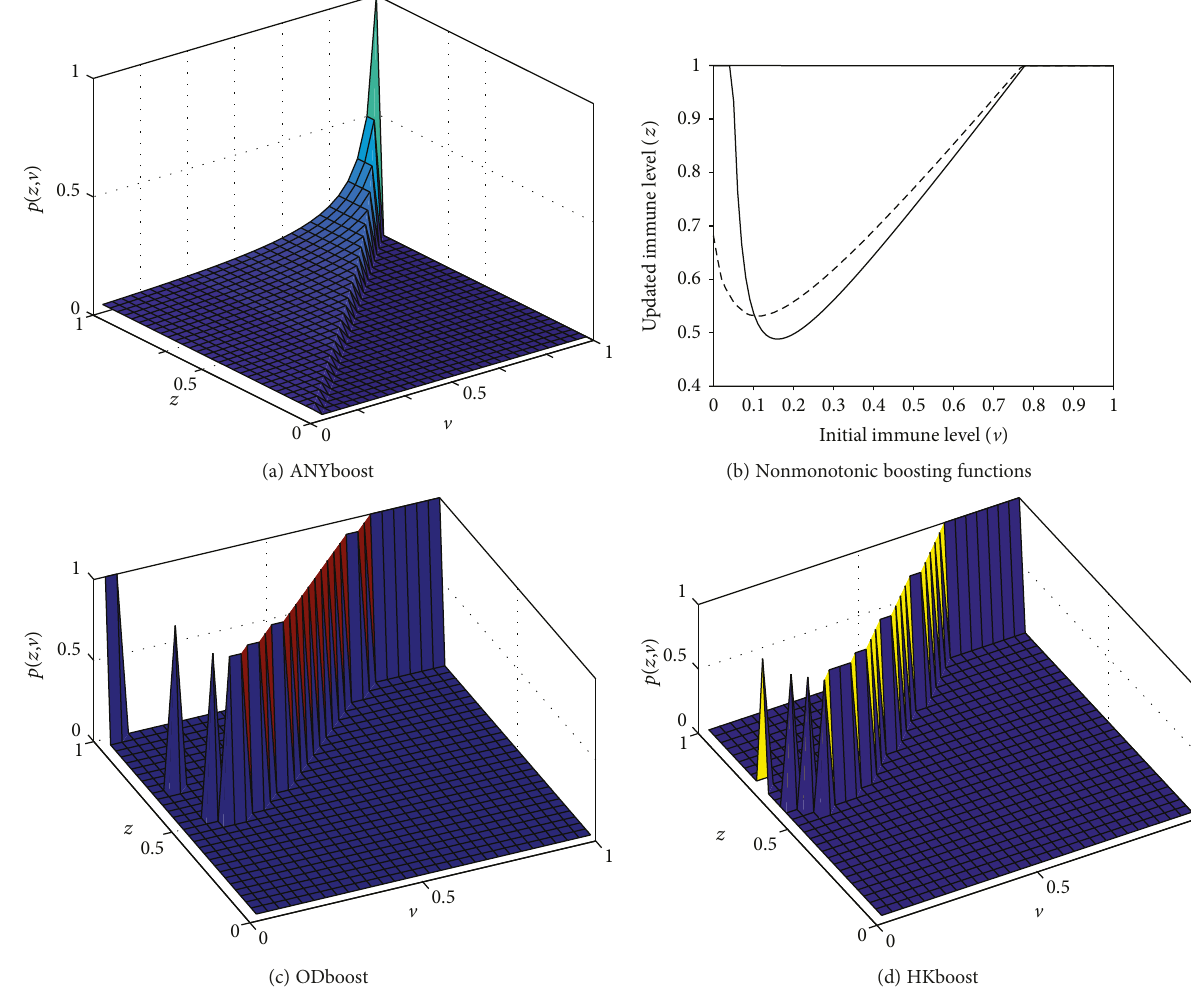
Figure 3: Nonmonotonic immune response mechanisms. (a, c, d) Examples of di ff erent boosting matrices Π for the numerical implementation of p z , v , the probability that individuals with immune level v at exposure are boosted to level z ≥ v after exposure. The immune status is represented in z min , z max = 0, 1 and discretized on an equidistant mesh with 30 points. (b) The dotted curve represents the boosting mechanism inspired by [6], the solid curve the one inspired by